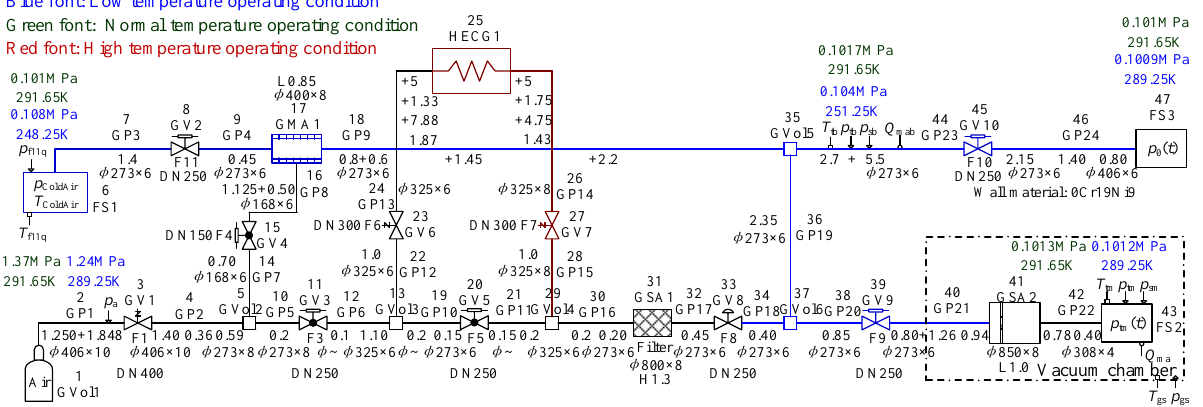
Figure 6. Numerical simulation model of the core engine test rig main test system. Numerical simulations are carried out for two test-rig regulating processes in a 0~1400 s normal-temperature operating condition and a 0~1240 s low-temperature oper- ating condition, respectively. In Figure 6, the length (unit: m), the outer diameter, and the wall thickness (unit: mm) of each pipe are given; the flow-field grid of the pipe-type com- ponent is divided into 100 mm/grid; the length of the lumped parameter component (such as gas valve, gas volume, etc.) in the direction of pipeline is two standard grids, i.e., 200 mm; and the total volume of the air source (composed of many high-pressure cylinders) is set according to specific operating condition, i.e., 10,000 and 500 m 3 for normal-temper- ature condition and low-temperature condition, respectively. The simulation gives initial flow field and pipe-wall temperature field distribution which are close to the actual situ- ation, and the test data are used for FS1–3 three fluid source boundary conditions. The pipe-wall radial 1D heat transfer model is used for the GP, GV, and GSA module components; the wall 0D heat transfer model is used for the GVol module components; and the wall adiabatic treatment is given for the GMA module component. The total num- ber of wall radial grid serial number of the components using the 1D heat transfer model is four. The heat exchange between the exterior walls of various components and the outer environment is considered as simple superposition of convection heat transfer and radia- tion heat transfer, where the convective heat transfer coefficient is set at 6 W/(m 2 K) for the sections of normal-temperature air, at 10 W/(m 2 K) for the section behind GP21, and at 0.1 W/(m 2 K) for the section with coating layer. The outer environment temperature is 291.65 K in normal-temperature operating condition and 289.25 K in low-temperature operating condition. The ten regulator valves are modeled as gas valve module components, and by a large amount of simulation debugging, the throttling calculation scheme is set, as shown in Table 2. In the table, the flow-rate characteristic fitting formula scheme of Vanessa 30,000 pneumatic zero-leakage butterfly valve is used as the flow coefficient calculation scheme for GV2 (F11), GV9 (F9), and GV10 (F10), and the three valves correspondingly adopt the injector orifice model scheme of IEC60534-1998 standard-based expansion coef- ficient method; with HCB cage-type double-seat high-capacity sleeve regulator valve [25]